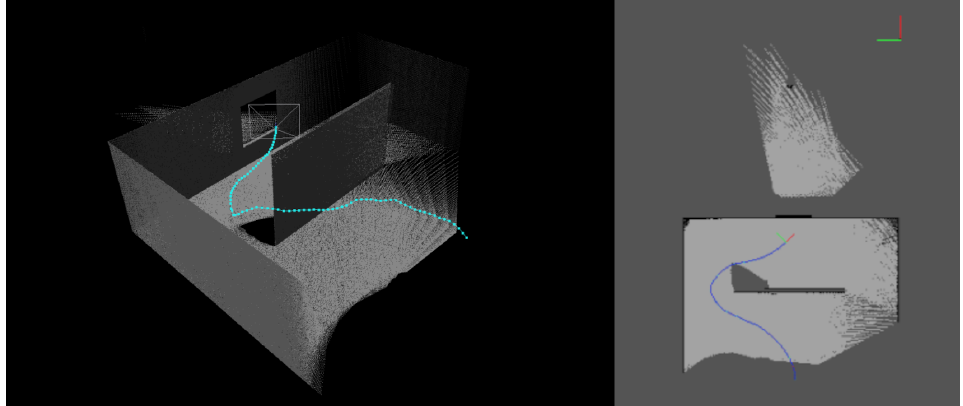
Figure 19. Using SLAM for visualizing the trajectory of UAV controlled by the SCAN algorithm (Beginning of Area 1). In this paper, SLAM is used only for visualization purposes.